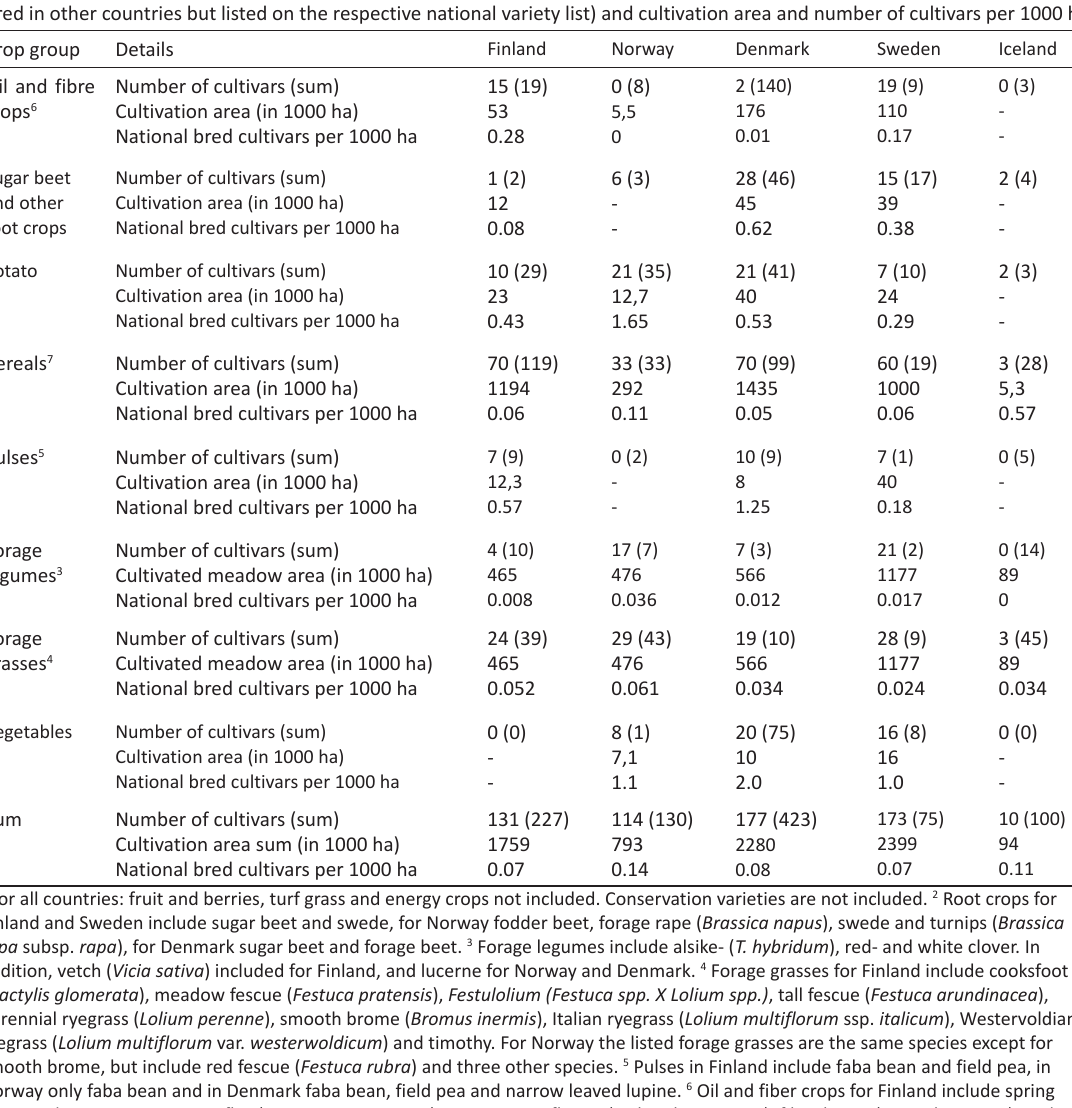
Table 2. Number of cultivars bred in the country and listed on respective national variety list in 2014 1 (in parenthesis is the numbers bred in other countries but listed on the respective national variety list) and cultivation area and number of cultivars per 1000 ha Crop group